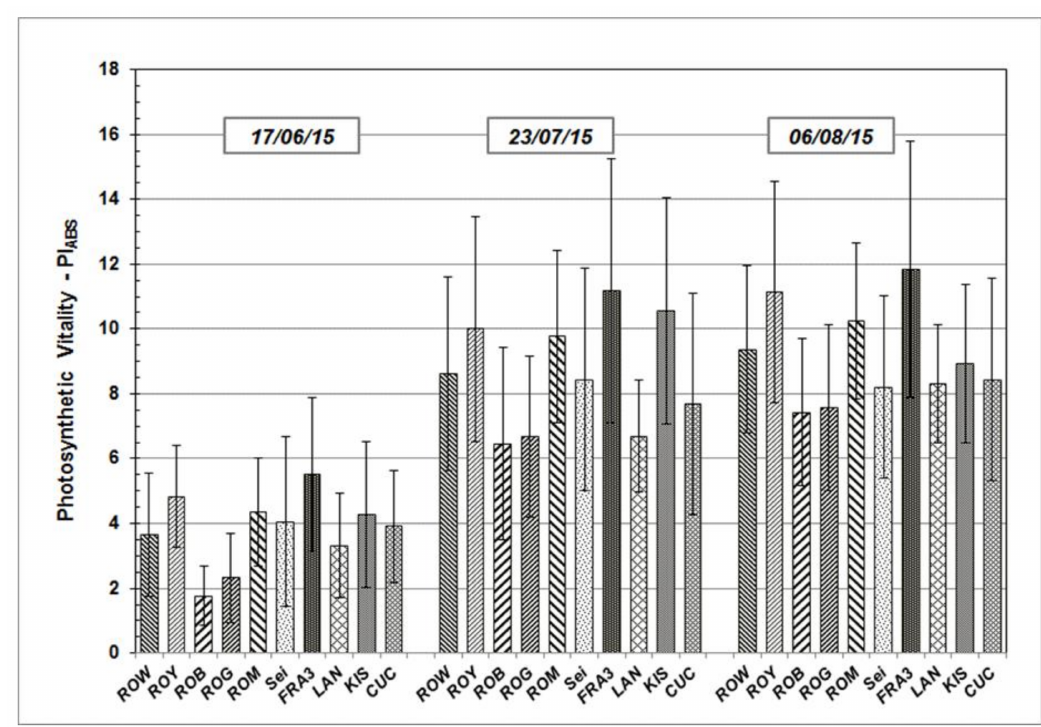
Figure 3. PI ABS mean values and standard deviation of Black Locust clones and provenances during the growth season 2015 at clonal test plot Welzow .